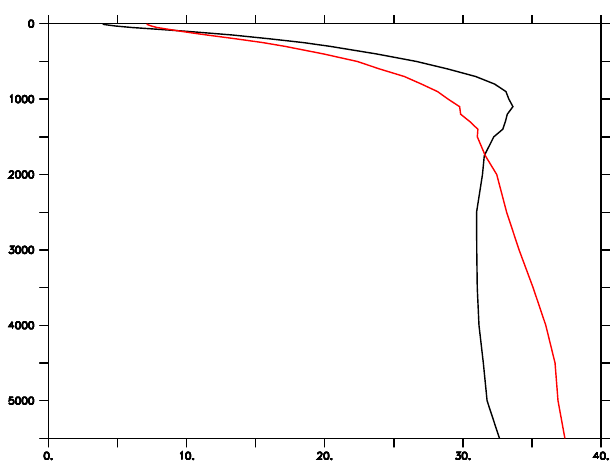
Figure 8. Depth (m) profile of average NO − (µmolL − 1 ). Black line: WOA2009 synthesis of observations, not interpolated. Red line: model results sampled at the places where there are